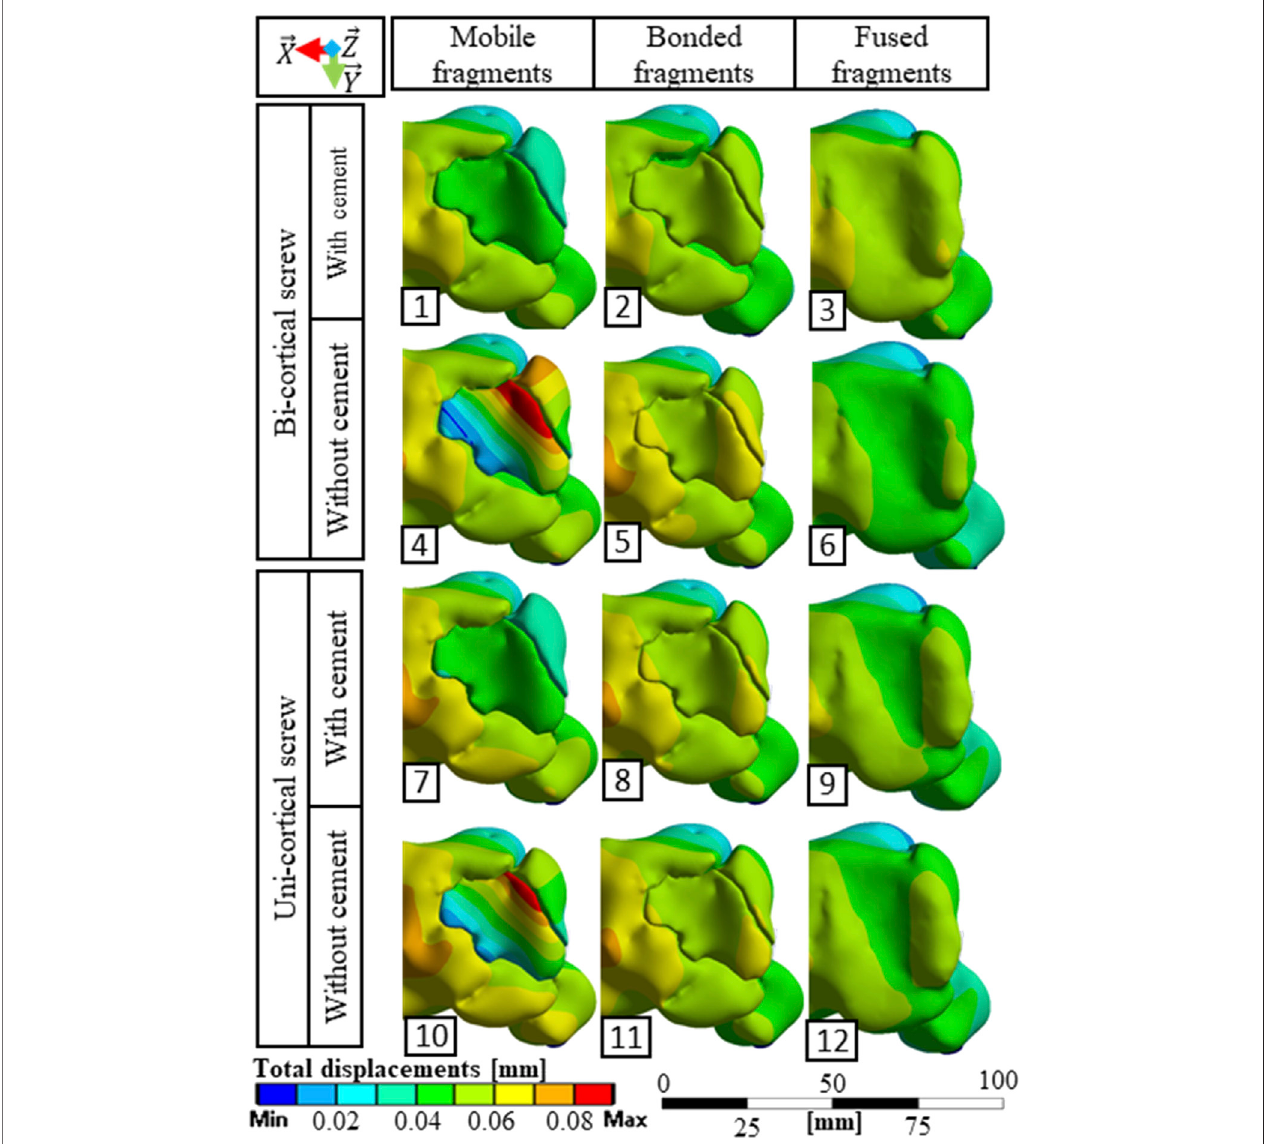
FIGURE 4 | Total displacement fi elds observed from a superior point of view for the 12 simulated